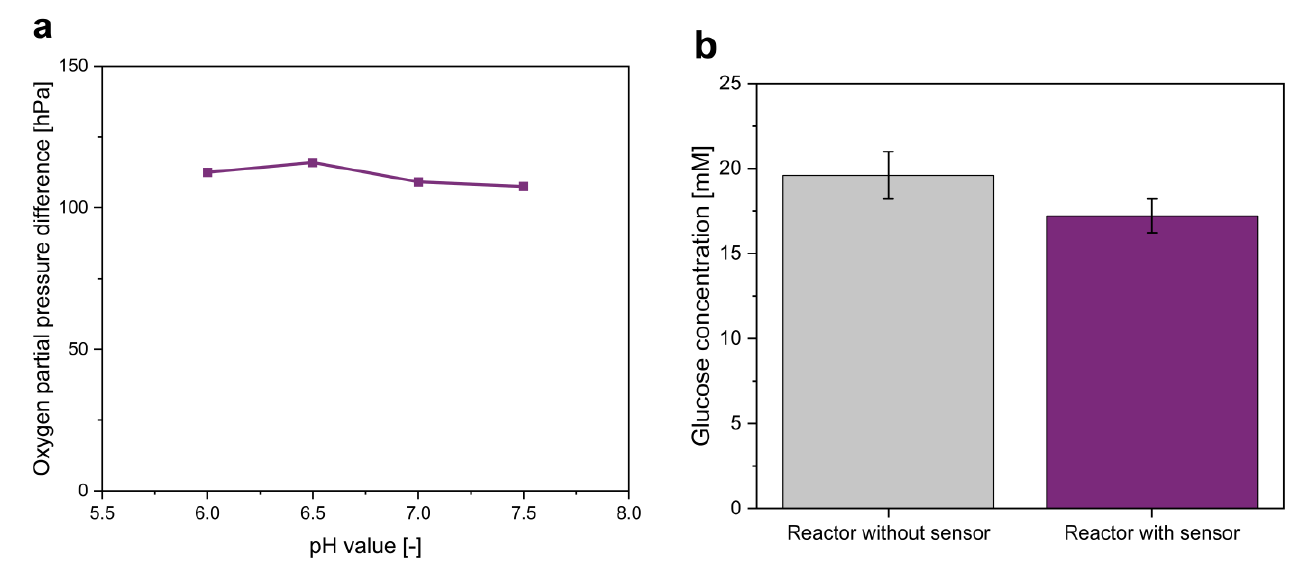
Figure 5. ( a ) Oxygen partial pressure difference between oxygen and glucose sensors of a 10 mM glucose solution in phosphate buffer at different pH values. The results indicate neglectable pH influence at relevant pH values; ( b ) glucose concentration determined via HPLC in cwMBRs after incubation with or without a glucose sensor after 24 h with an initial glucose concentration of 20 mM. The results illustrate the low glucose consumption of the optical glucose sensor.